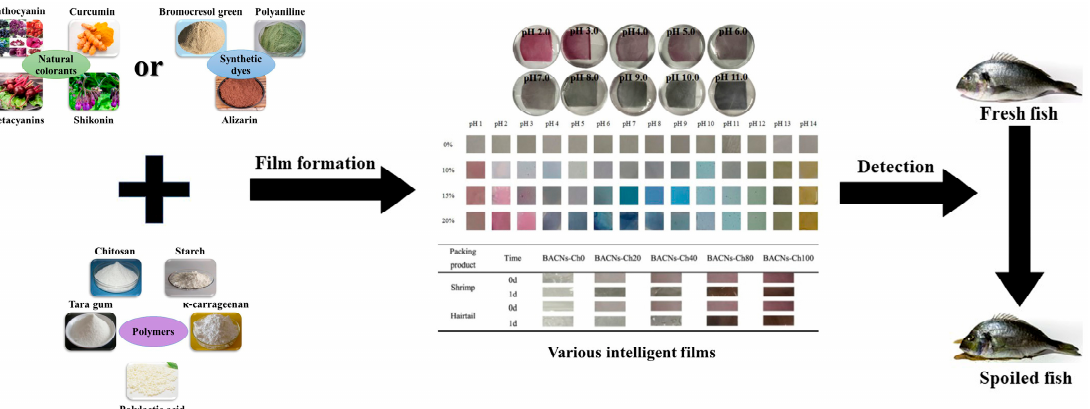
Figure 2. Manufacturing process and application of intelligent indicator.